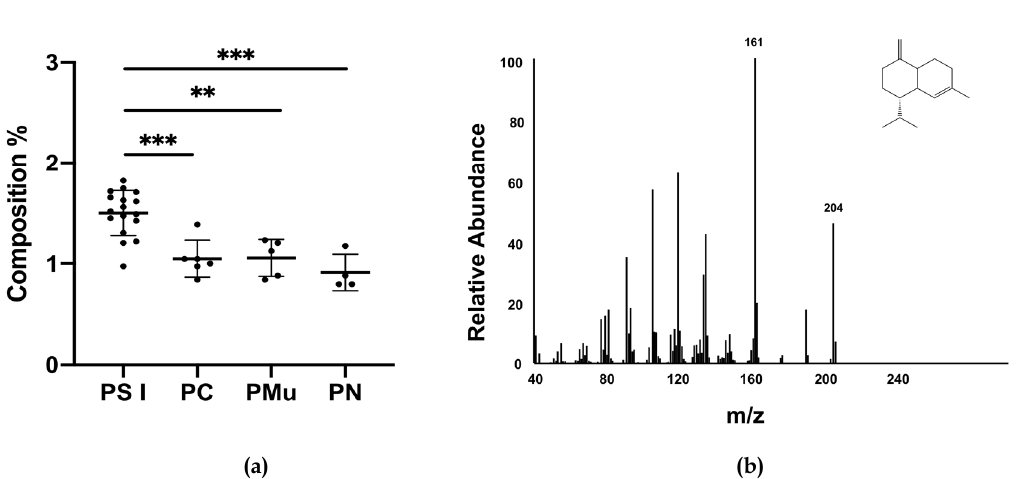
Figure 6. ( a ) γ -cadinene as potential chemical marker for characterizing primary EOs of PS I. Significance was tested using ANOVA followed by Tukey post-hoc test with p < 0.01: ** and p < 0.001: ***. ( b ) Mass spectrum of γ -cadinene.